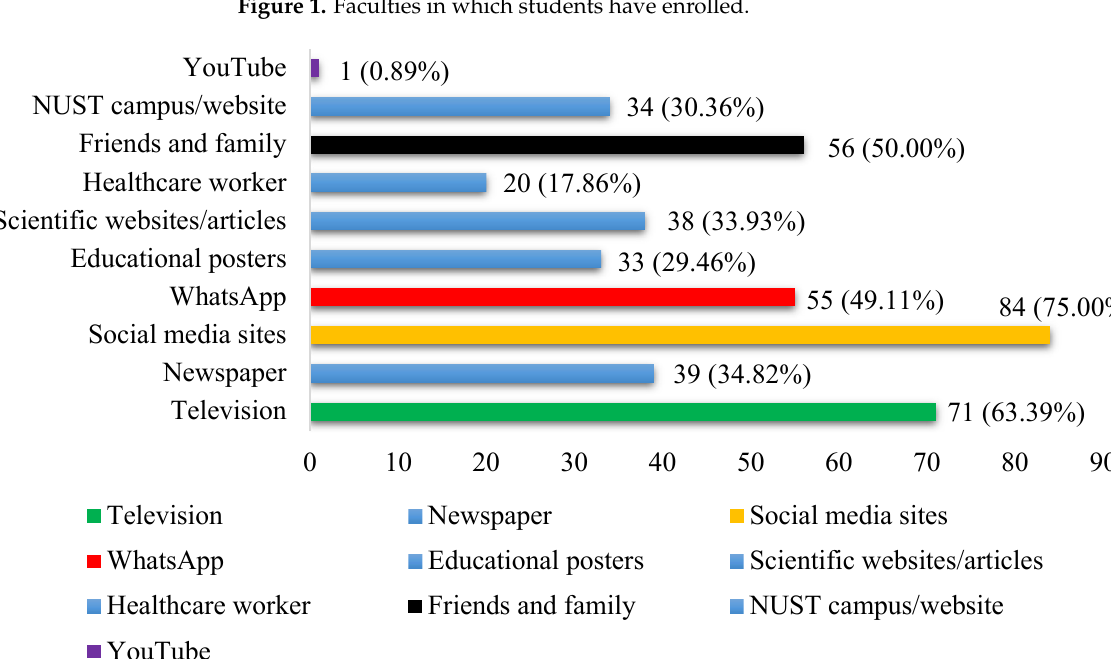
Figure 2. Sources of information about COVID-19 students’ levels of knowledge about COVID-19. The students’ levels of knowledge about COVID-19 were assessed in three different sections, using modes of transmission, protective measures, and clinical symptoms. For each section, the correct answers were expressed using frequencies and percentages. The mean score of each section was calculated by adding the mean values of each question.